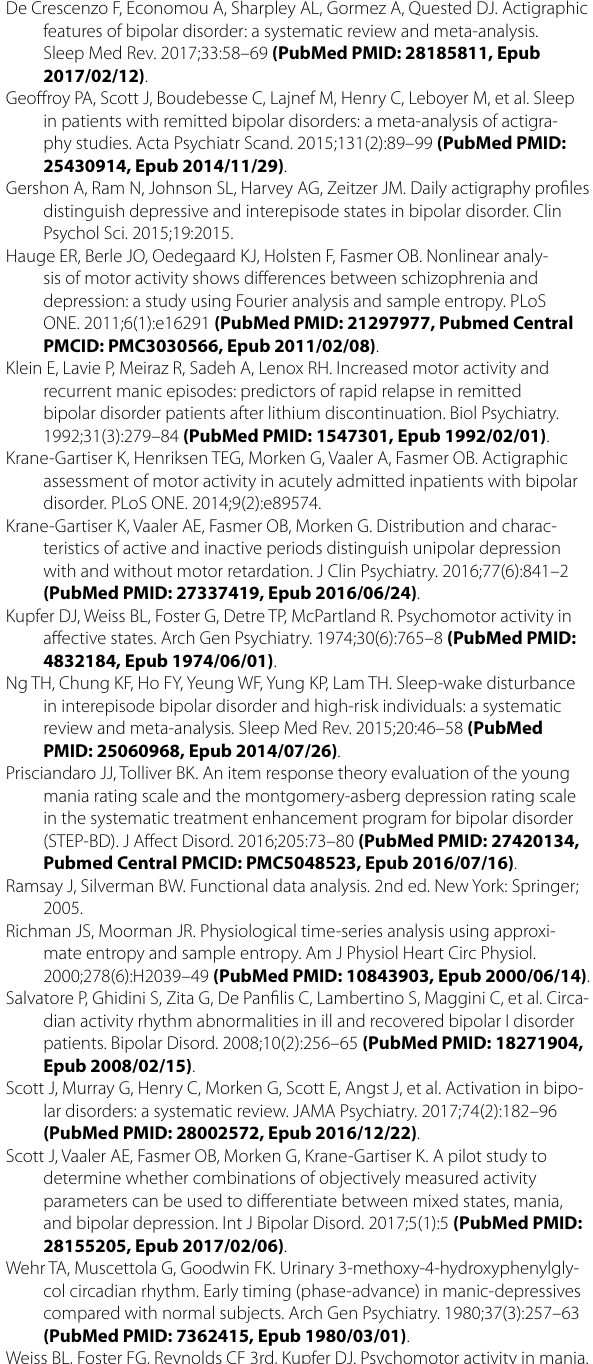
Classification of Diseases, 10th revision; IRT: item response theory; R1: record‑ ing one; R2: recording two; R3: recording three; RMSSD: root mean squared successive difference; SD: standard